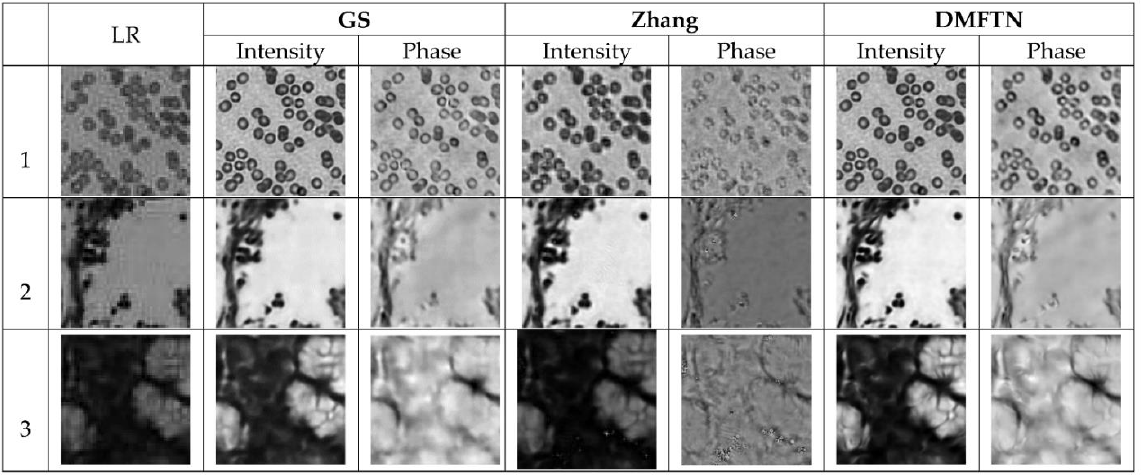
Figure 13. Reconstruction results on the actual dataset. Table 3. Comparison of reconstruction time of four